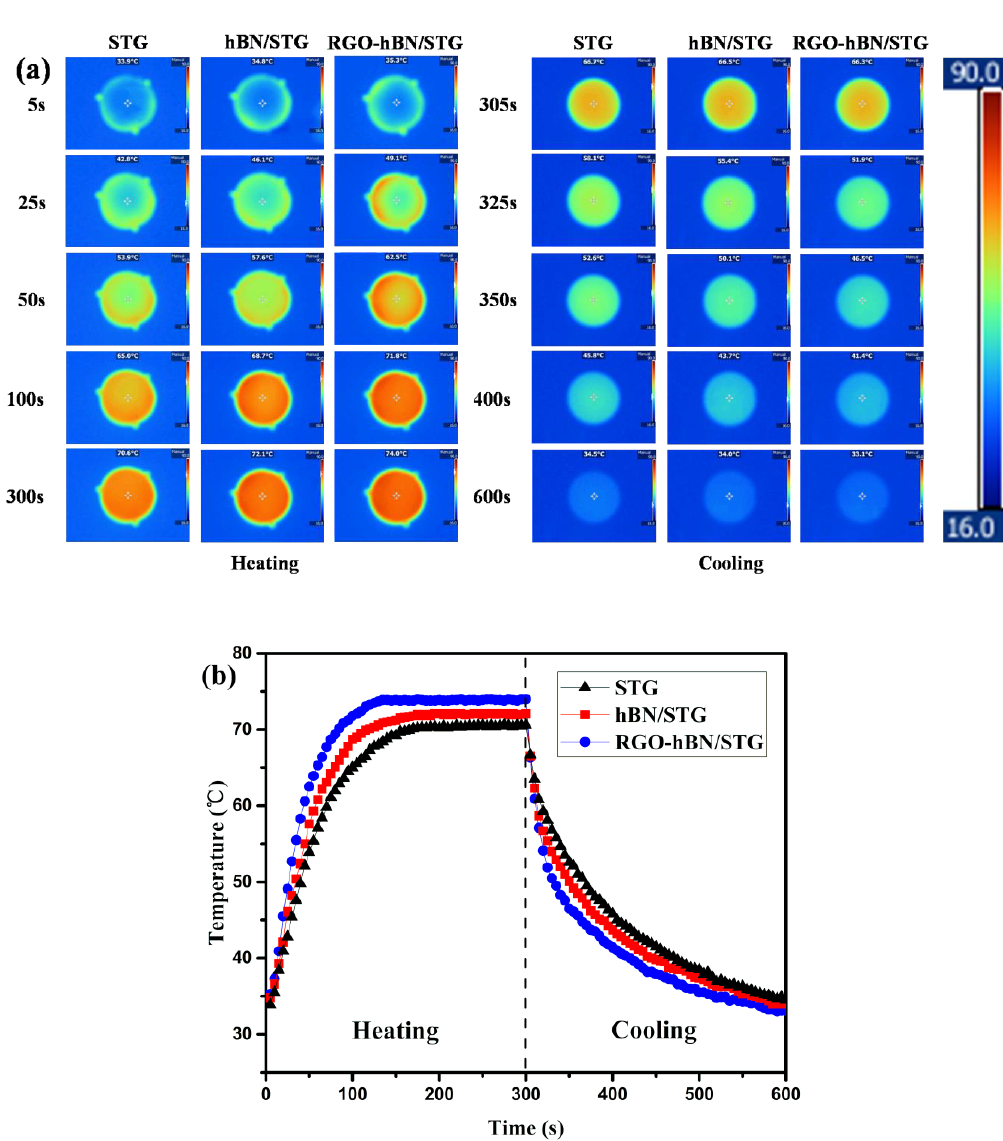
Figure 7. ( a ) Images recorded by a thermal imager with specimens heated on a homothermal platform and ( b ) the surface centre temperature profiles of the samples as function of heating